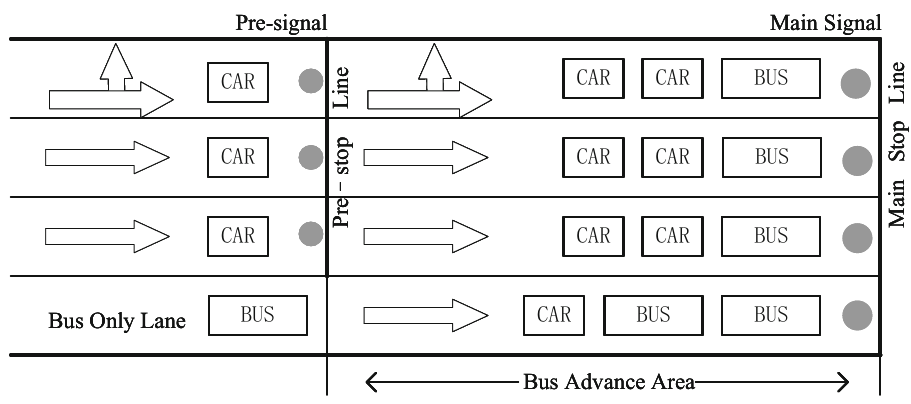
Fig. 1 Pre-signal mechanism schematic